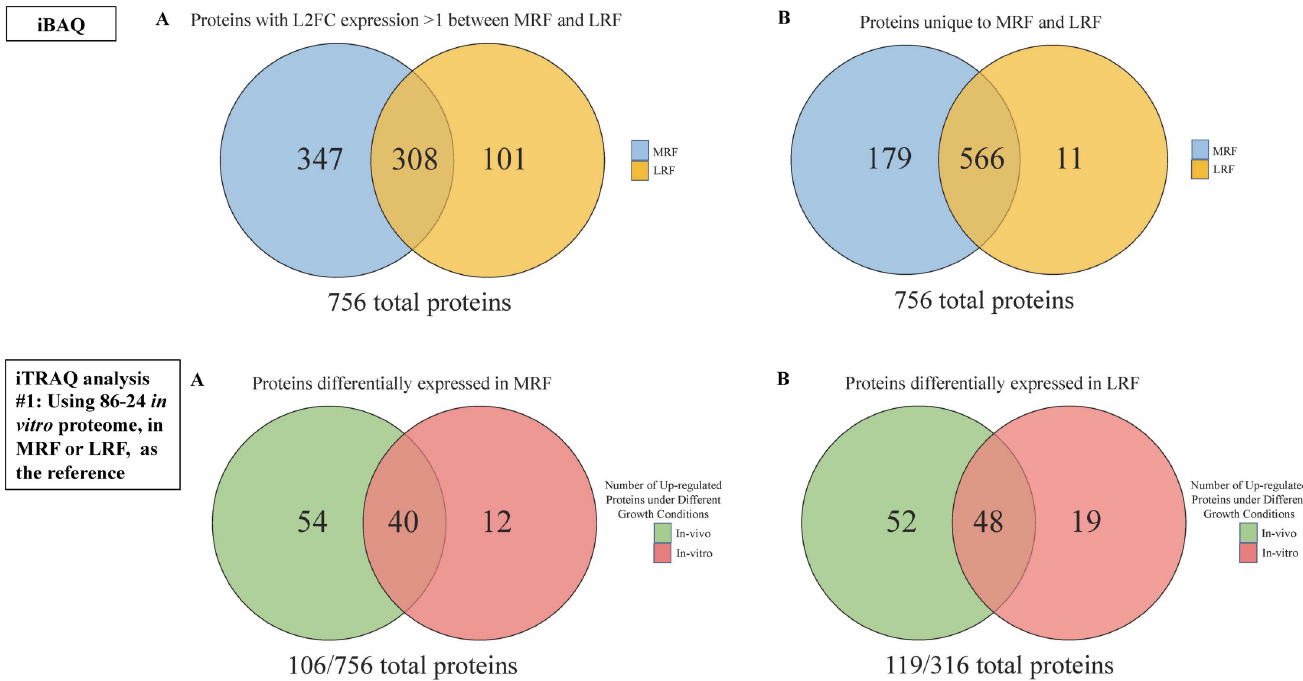
Fig 4. Analysis of O157 proteome as expressed in MRF and LRF, under different diet and growth conditions, using iBAQ and reference-based iTRAQ analysis #1. iBAQ: A. Venn diagram showing the number of O157 proteins differentially expressed (L2FC > 1) between MRF and LRF. B. Venn diagram showing the number of O157 proteins uniquely expressed in MRF and LRF. iTRAQ analysis #1 (reference-based): A. Venn diagram showing number of differentially expressed proteins in the in vitro and in vivo growth conditions, relative to the 86–24 in-vitro proteome, in MRF. B. Venn diagram showing number of differentially expressed proteins in the in vitro and in vivo growth conditions, relative to the 86–24 in-vitro proteome, in LRF.